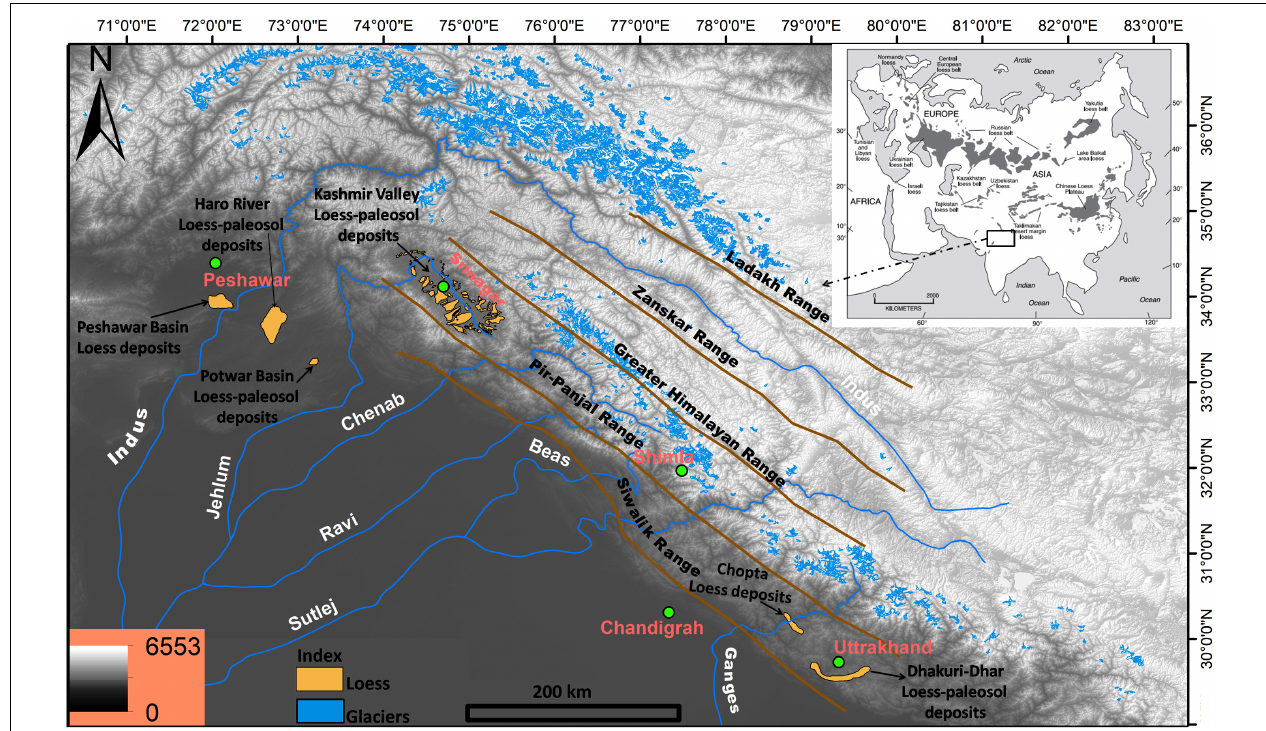
FIGURE 1 | The upper right inset is showing the distribution of loess in Eurasia after Muhs and Bettis (2003) with focus on the region around Kashmir. Enlarged (SRTM DEM derived hill shade) map showing the distribution of loess in India and Pakistan (as reported), modified after (Bhatt, 1982; Akram et al., 1998; Pant et al., 2005). Glacier cover is taken from RGI Consortium (2017) and major rivers and sub-Himalayan mountain ranges are after Brookfield